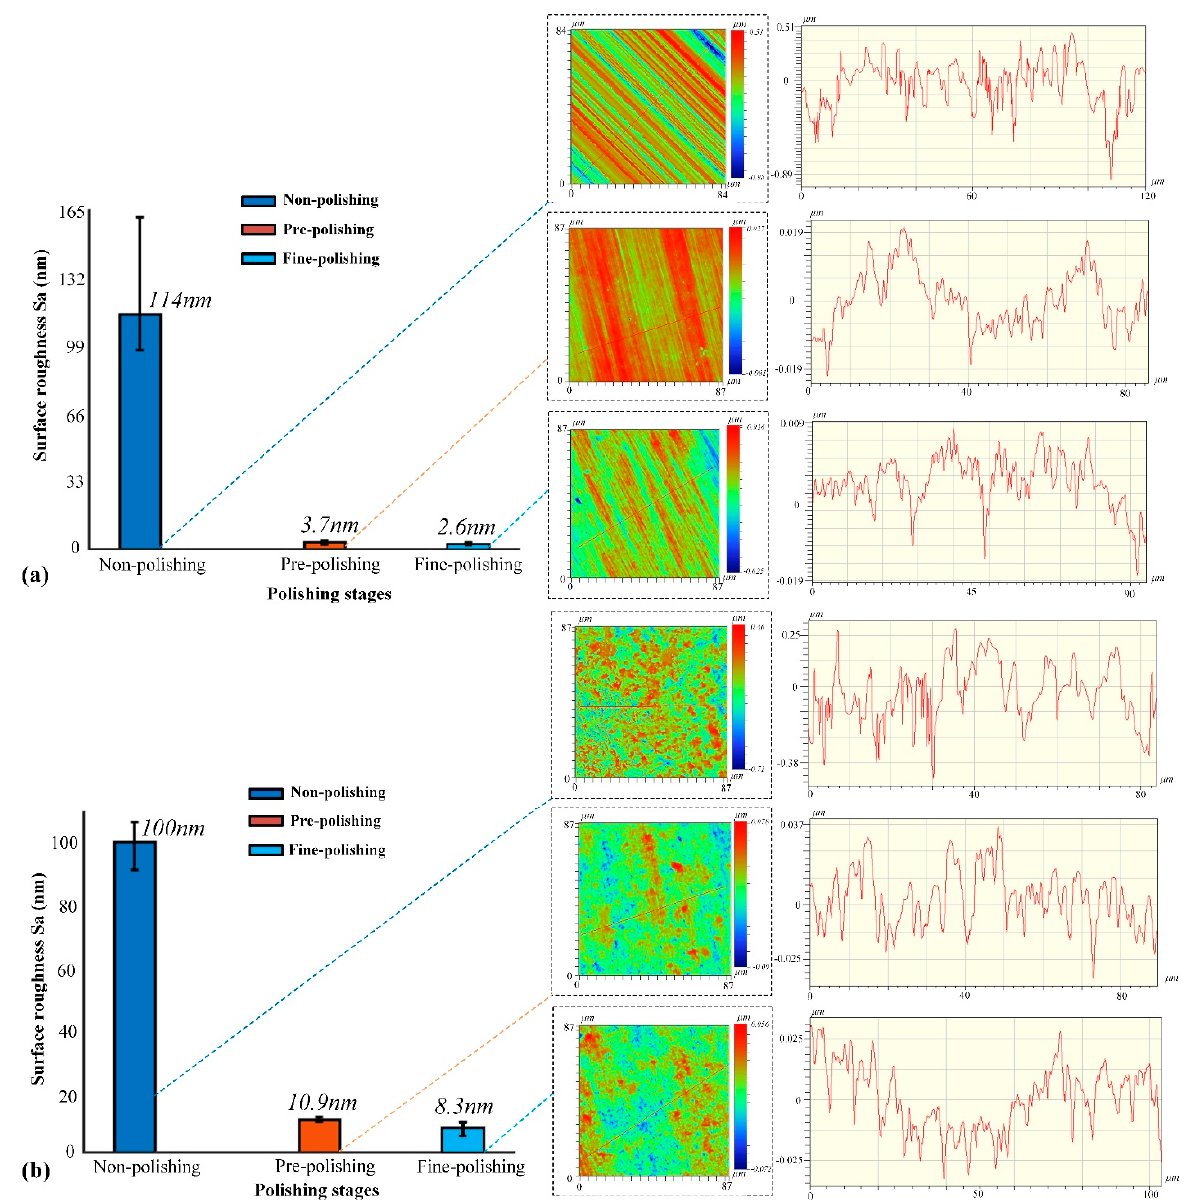
Figure 4. Surface roughness results at different polishing stages measured using a white light inter- ferometer. ( a ) WC-0Co; ( b ) WC-12Co. interferometer. ( a ) WC-0Co; ( b )